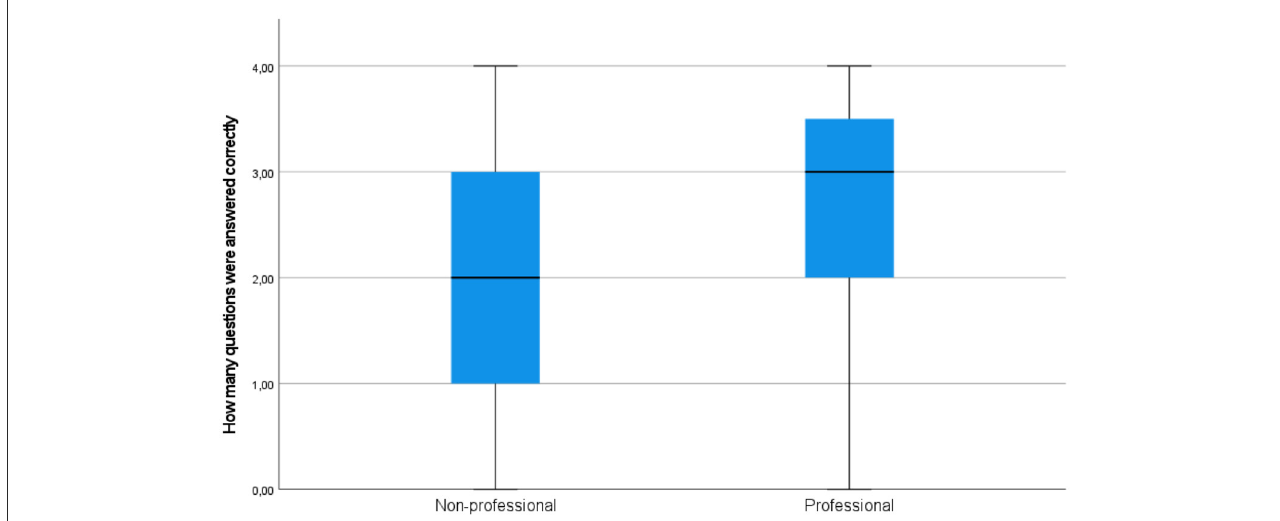
FIGURE11 A simple box plot of text comprehension results in the groups of professionals and non-professional users.